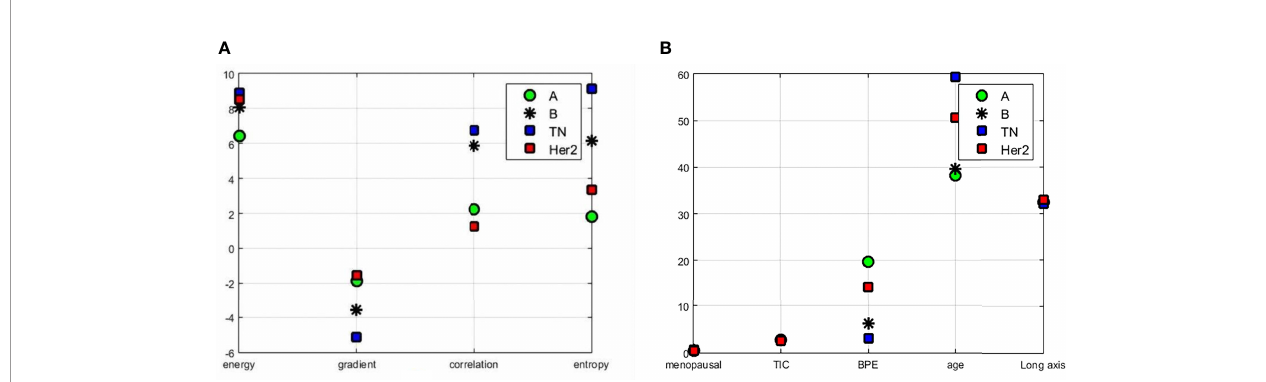
FIGURE 2 | Results of features contrast of the different subtypes: (A) the representative gradient features including energy, gradient, correlation, and entropy; (B) the contrast results for clinic features which contain menopausal, TIC curve type, BPE classi fi cation value, patient age, and tumor length among the